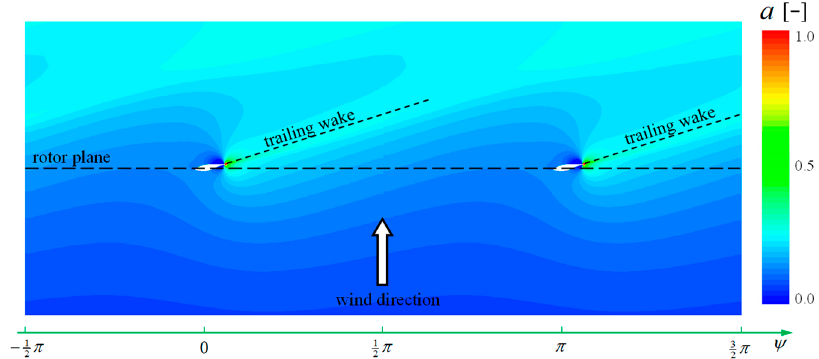
Figure 8. Contours of axial interference factor after self-induction subtraction in the flattened section of r / R = 47% ( 7m/s V ∞ = , 72rpm ω= ). Before subtraction After subtraction